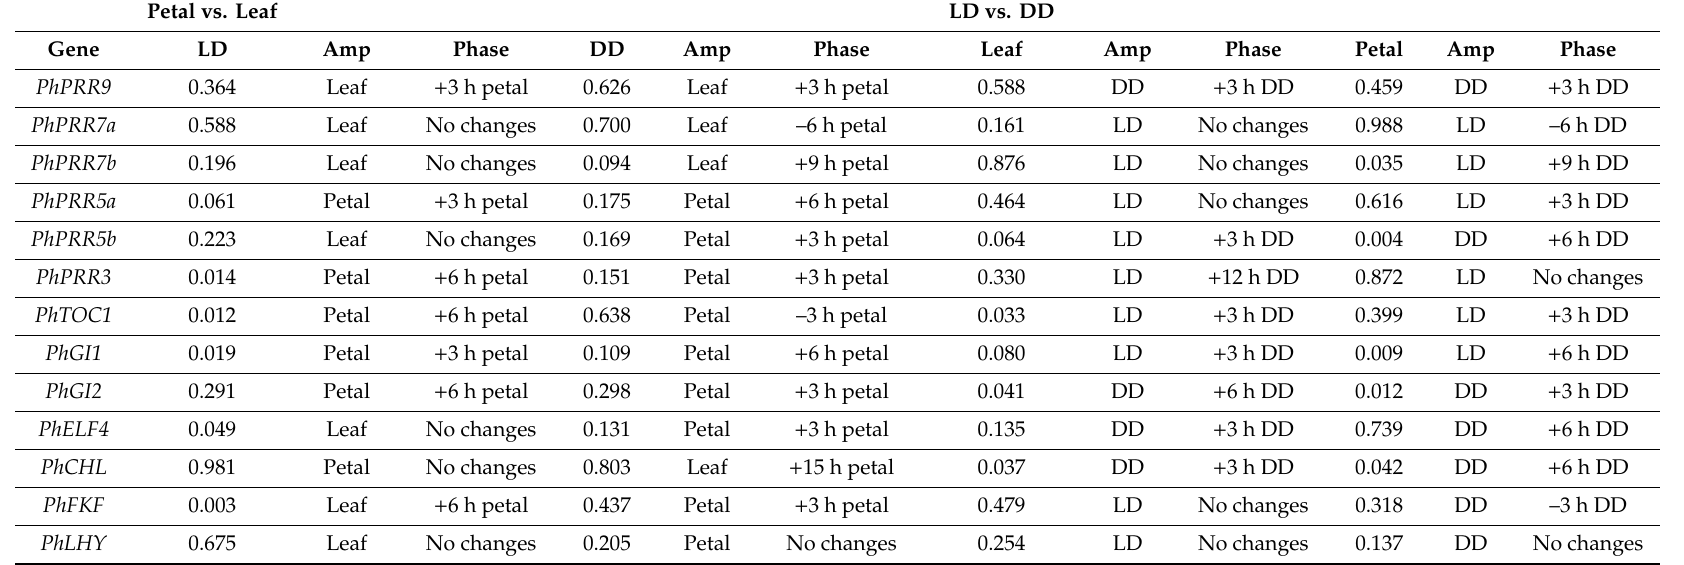
Table 2. Analysis of di ff erential gene expression in petunia leaves and petals under two light conditions: light:dark (LD) and constant darkness (DD). We compared the daily gene expression of both tissues (petal vs. leaf), under light:dark and constant darkness. We also compared every single tissue under two light conditions (LD vs. DD). This analysis uses Harmonic ANOVA (HANOVA) to test di ff erences in amplitude and phase. A p value < 0.05 indicated that the amplitude and / or phase were significantly di ff erent between tissues (petal vs. leaf) or between light conditions (LD vs. DD). Amp displays the tissue with the higher amplitude and Phase symbols + and – denotes delayed and advanced, respectively, per tissue or experimental condition.